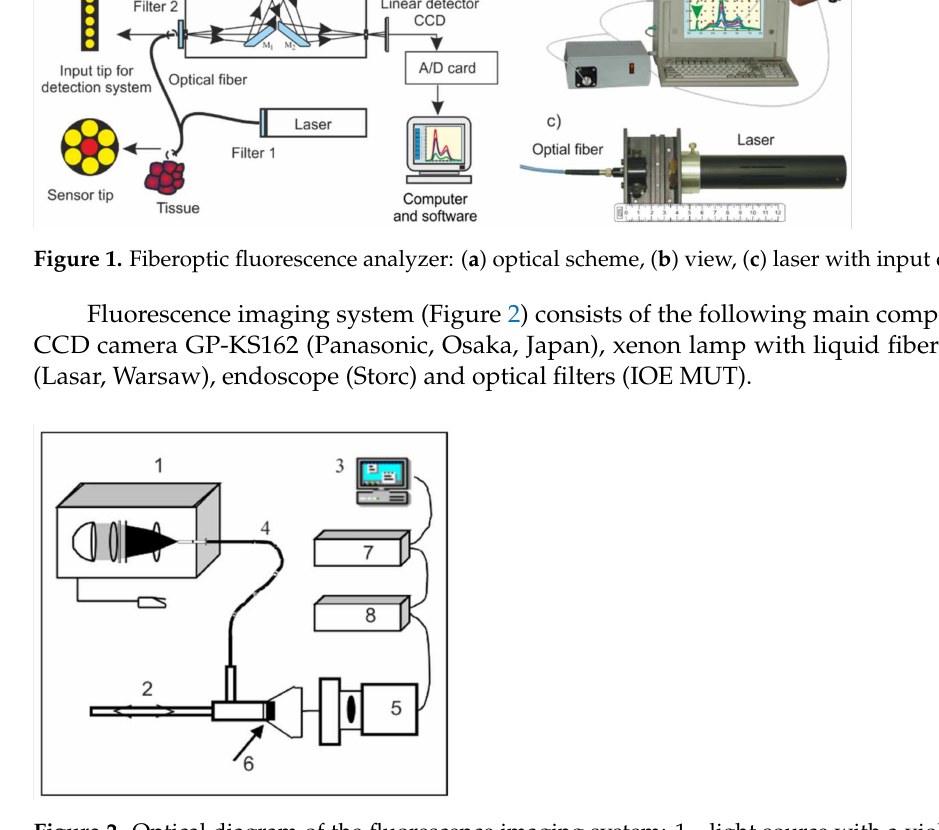
Figure 2. Optical diagram of the fluorescence imaging system: 1—light source with a violet filter ( λ = 405 ± 25 nm), 2—endoscope, 3—monitor, 4—liquid optical fiber, 5—CCD camera, 6—optical filter, 7—computer,